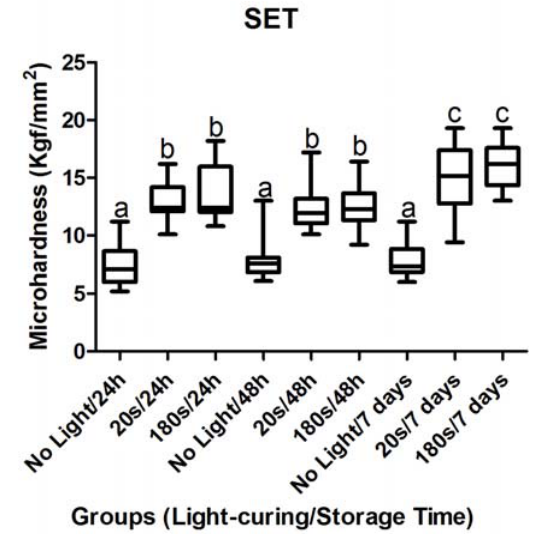
Figure 3. The mean values (Kgf/mm 2 ) were analyzed according to exposure time of light-curing and storage time for SET resin cement. Different letters (A–C) indicate statistically significant difference at 5% level (Tukey’s test; P <